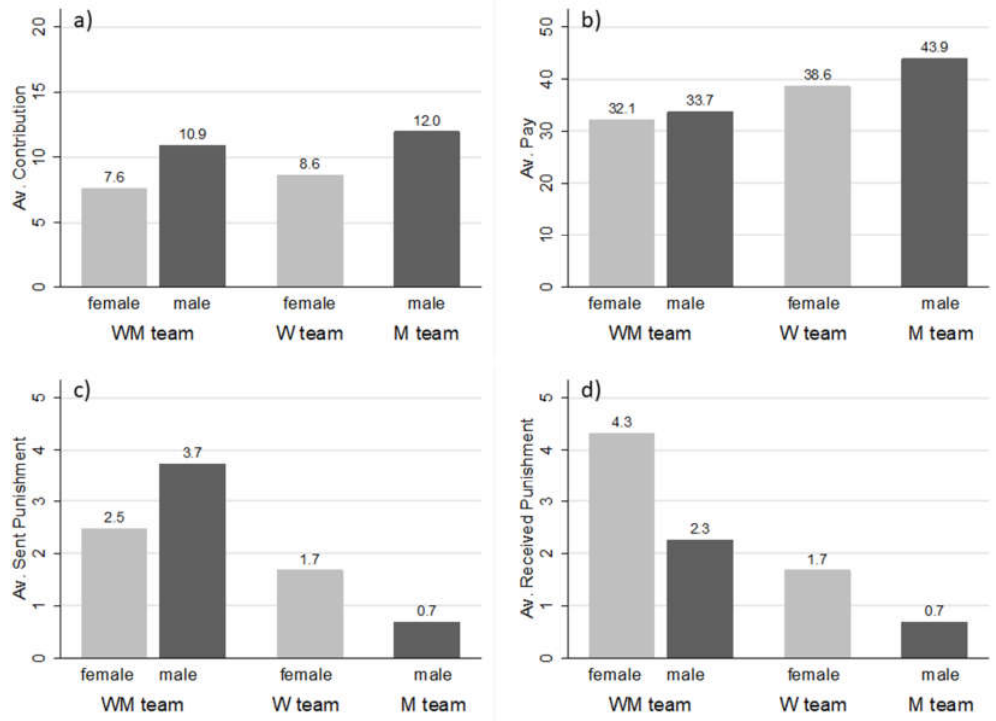
Figure 1. Average ( a ) contributions; ( b ) average pay; ( c ) average sent punishment points; and ( d ) average received punishment points; over all periods and teams, respectively.